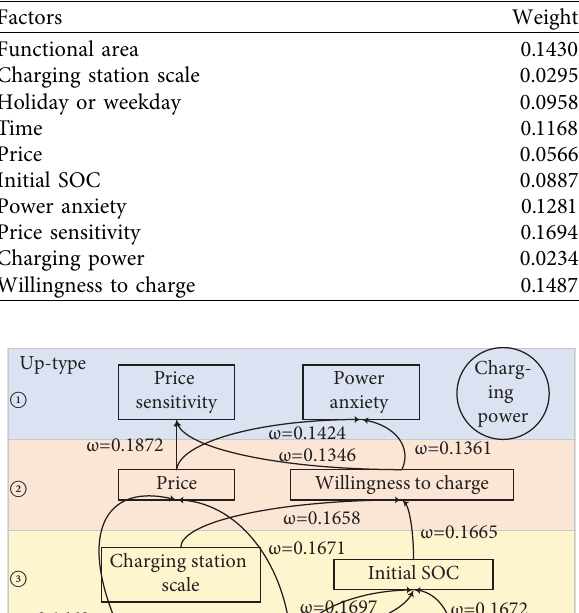
Table 3: Te weight of factors in the integrated system afecting users’ charging behavior.